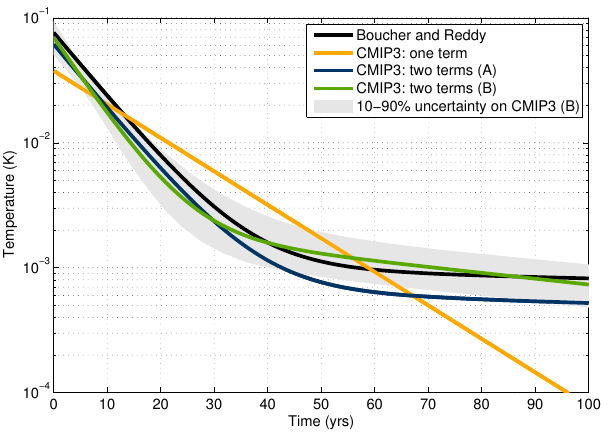
Fig. 2. The temperature response to a unit RF (log scale in temper- ature) from the Hadley model (Boucher and Reddy, 2008), and the CMIP3 ensemble mean with one exponential term and two expo- nential terms with different a priori values (Olivi´e et al., 2012). The IRF A uses an a priori estimate of 10 and 400yr, while the IRF B uses an a priori estimate of 10 and 100yr.